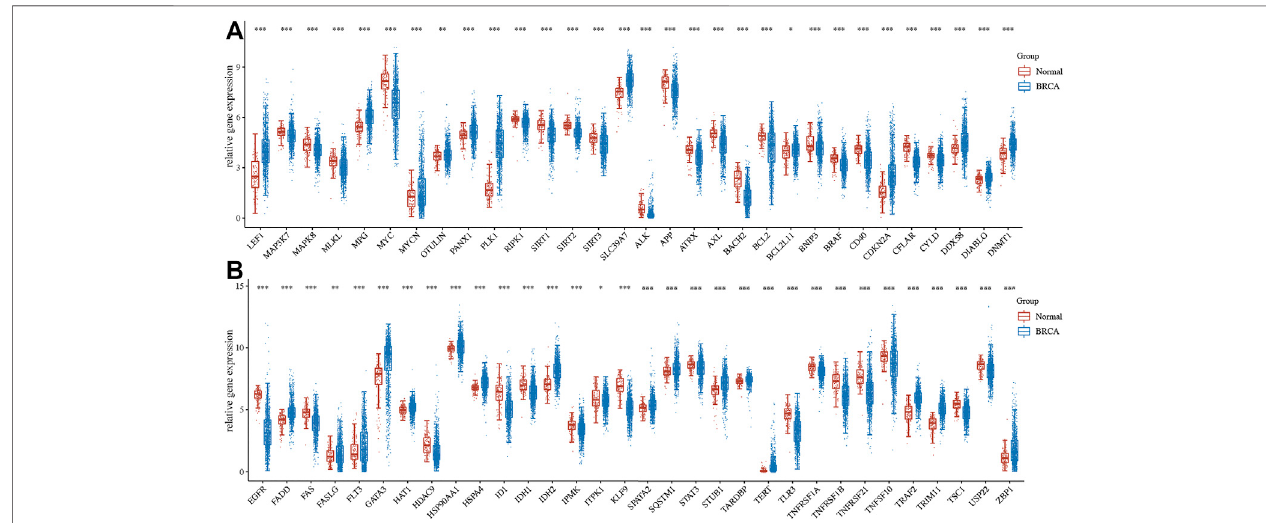
FIGURE 1| Gene expression ofnecroptosis-related gene in BRCA. (A – B) The mRNA level of necroptosis-related genes in BRCA versus breast tissues. * p < 0.05; ** p < 0.01; *** p < 0.001.